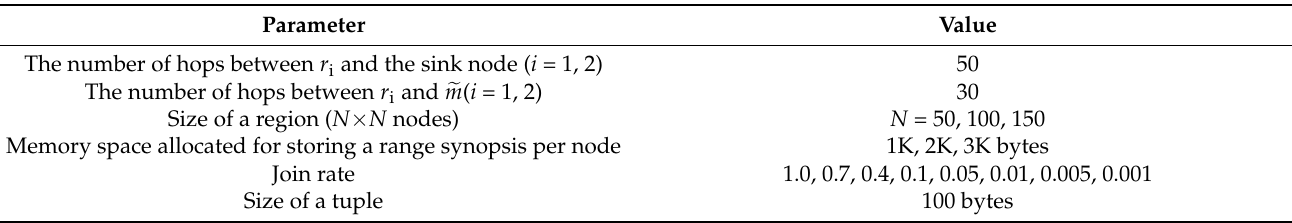
Table 1. Parameter settings in the simulations.